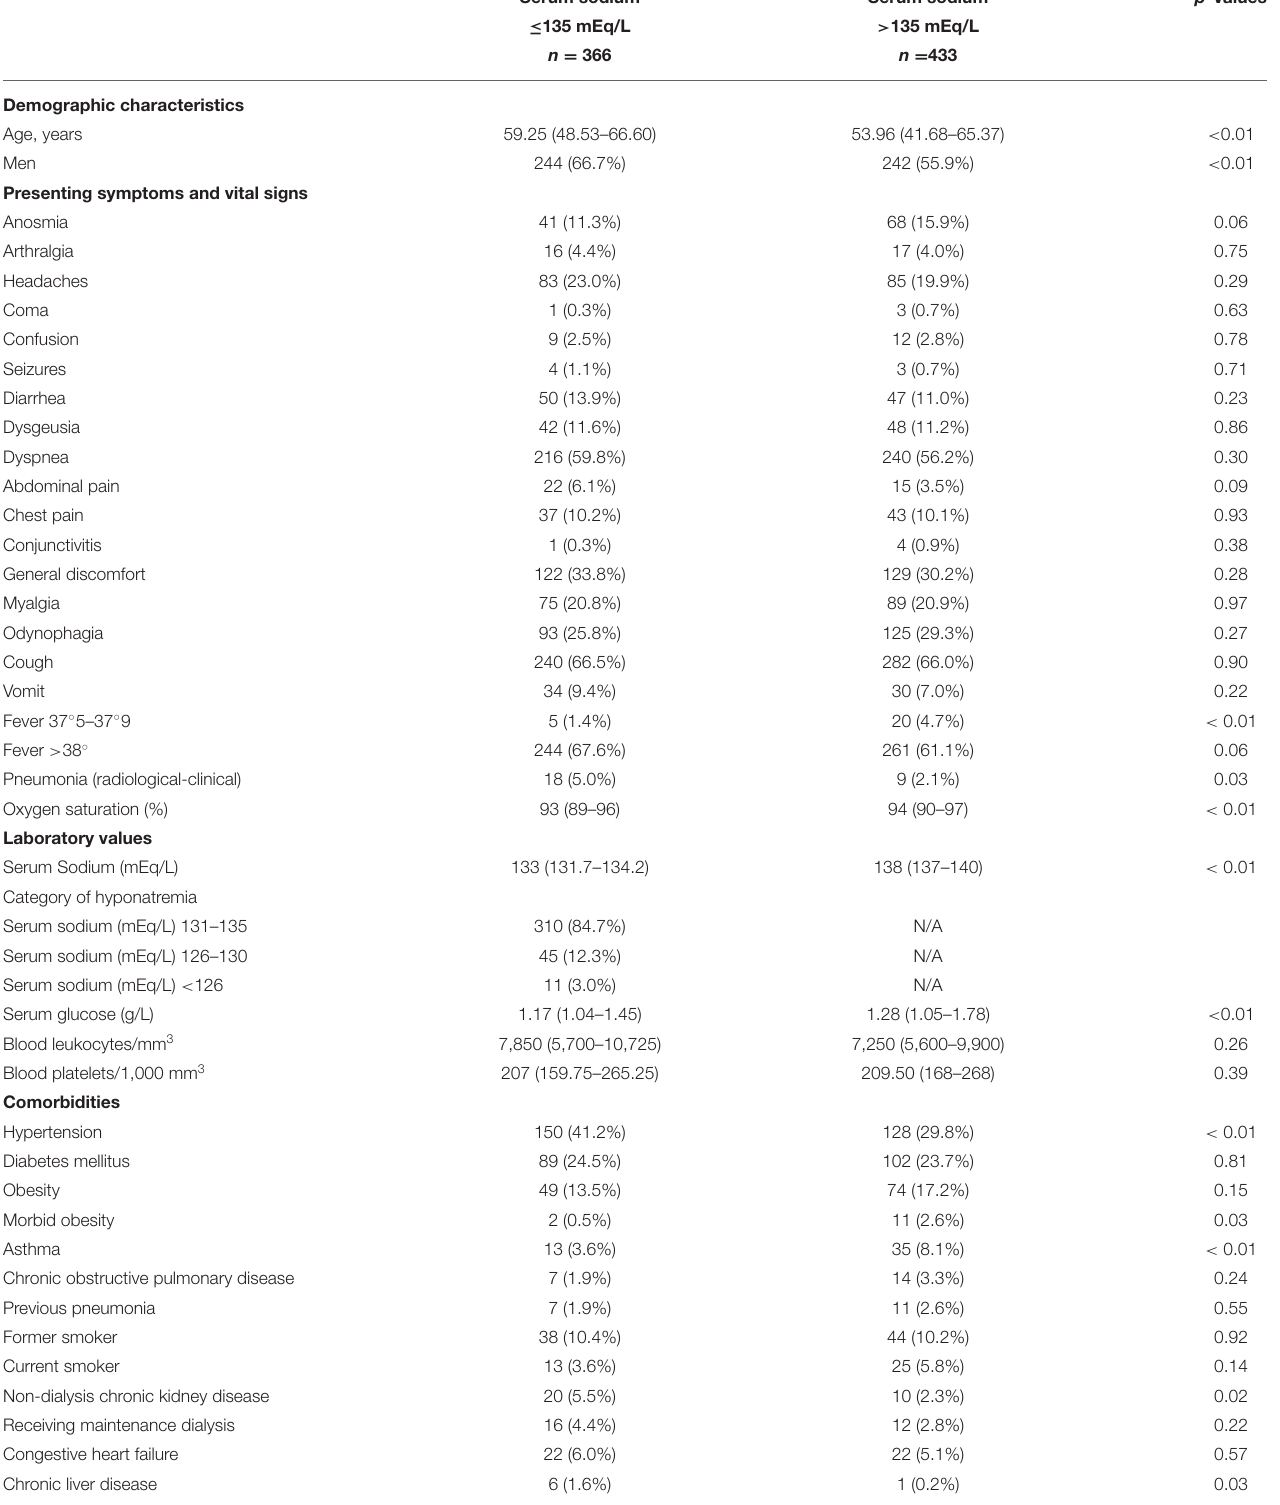
TABLE 1 | Demographic and clinical characteristics, laboratory values, and comorbidities in hospitalized patients with COVID-19 with and without hyponatremia on